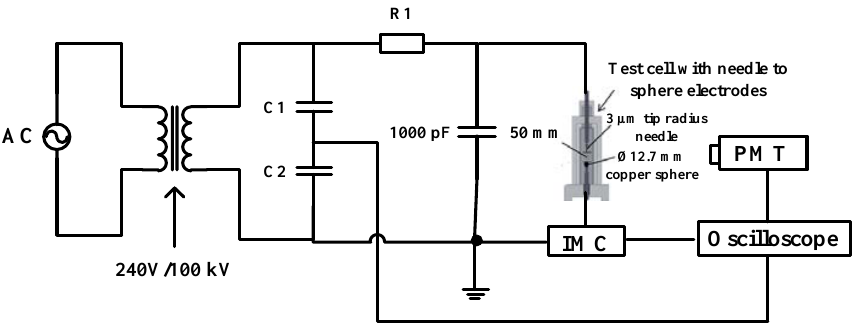
Figure 1. Configuration for partial discharge (PD) and photo multiplier tube (PMT) measurement.